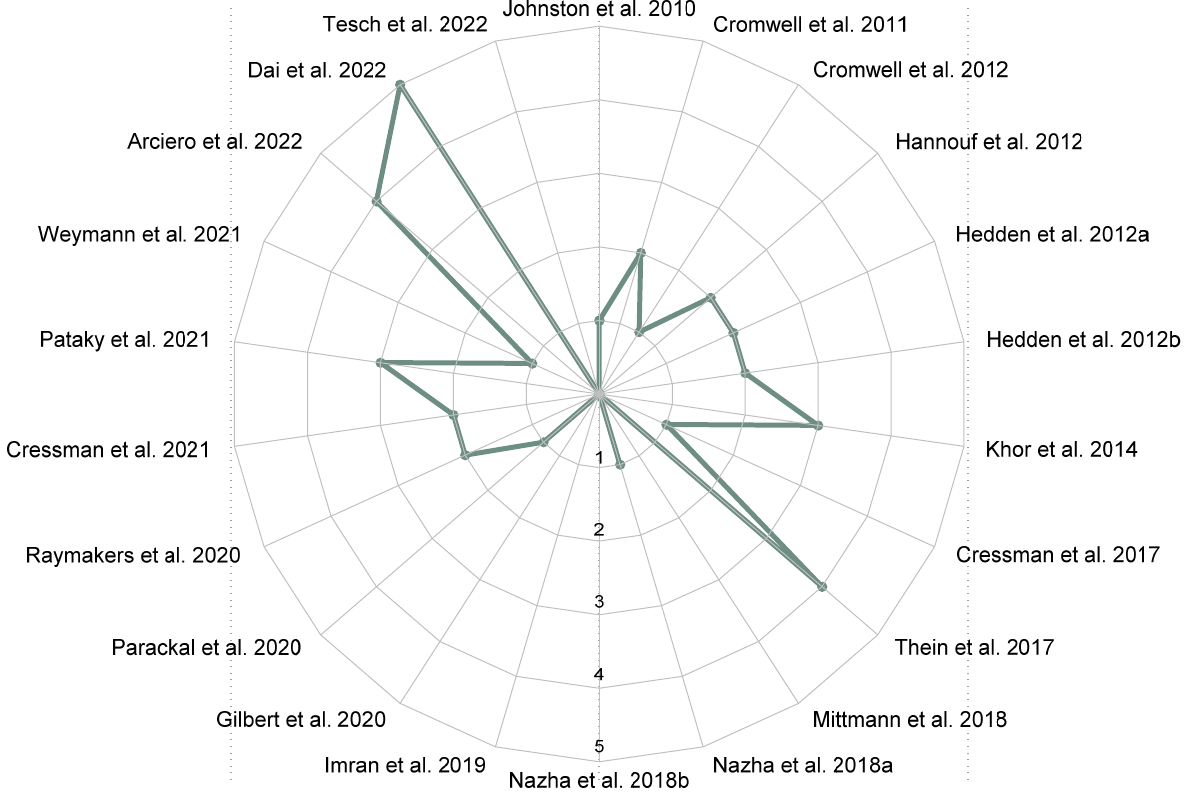
Figure 5. Radar graph illustrating the quantity of uncertainty methods by paper [13–34]. Through time, there is not a clear trend in how authors characterize